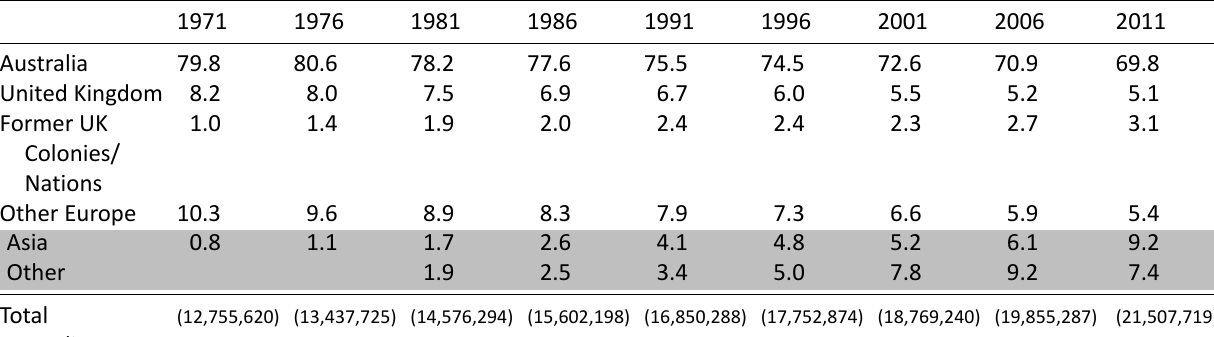
Table 2. Birthplace origins of the Australian population, percent, 1971–2011.